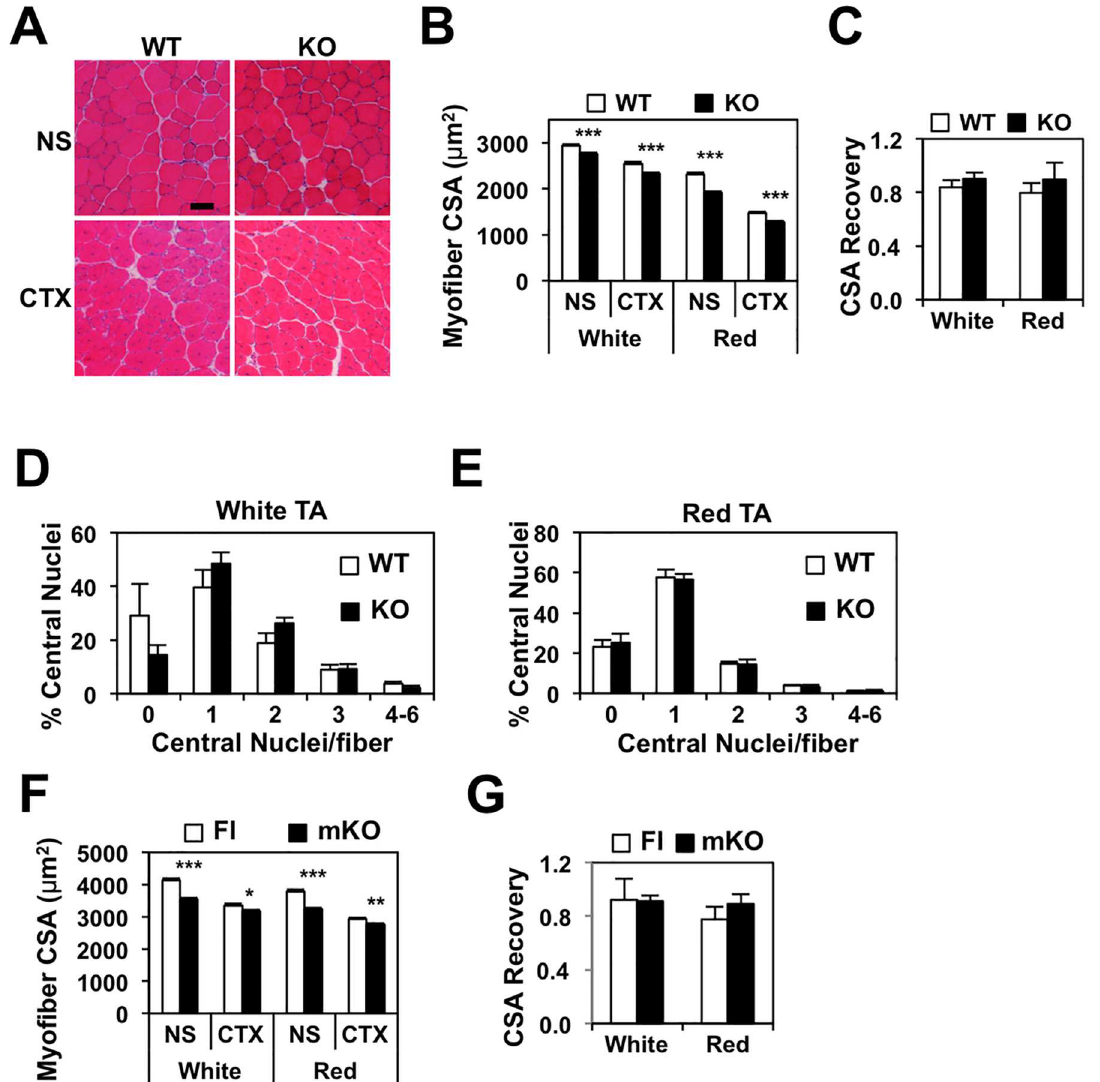
Fig 6. Cardiotoxin-induced muscle regeneration in Nur77-deficient mice. (A) H&E stains of cryosectionsfrom TA muscle isolated15 days after normal saline(NS) or cardiotoxin (CTX) injection. Scale bar = 500 μ m. Mean myofiber CSA, recovery of myofiber CSA, and percentageof myofibers with central nuclei from globalNur77 KO (B-E) and mKO (F-G) mice. N = 6–7 for B-E, 5–6 for F-G. * P < 0.05, ** P < 0.01, *** P <